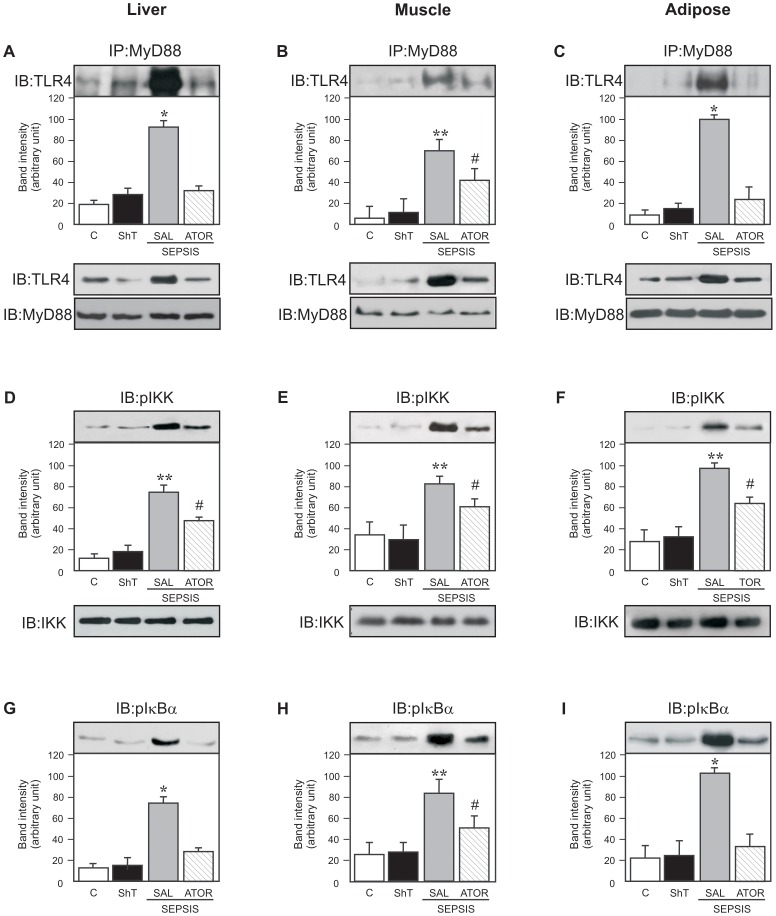
To evaluate the association of TLR4 with MyD88, immunoprecipitations were performed with MyD88 antibody followed by immunoblotting with TLR4 specific antibody.Representative blots show TLR4 activation (upper panels) and expression (lower panels) in liver (A), muscle (B) and adipose tissue (C) of sham and septic rats. IKKβ phosphorylation in liver (D), muscle (E) and adipose (F) of sham and septic rats. Total protein expression of IKKβ (D–F, lower panels). Phosphorylation of IκBα in liver (G), muscle (H) and adipose (I) of sham and septic rats. Data are presented as means ±S.E.M from 6–8 rats per group. *P<0.05 (Sepsis/Sal vs. all other groups); **P<0.001 (Sepsis/Sal vs. control); #P<0.05 (Sepsis/Sal vs. Sepsis/Ator). IB, immunoblot; CLT: Sham/Saline; ShT: Sham/Atorvastatin; SAL: saline; ATOR: atorvastatin.